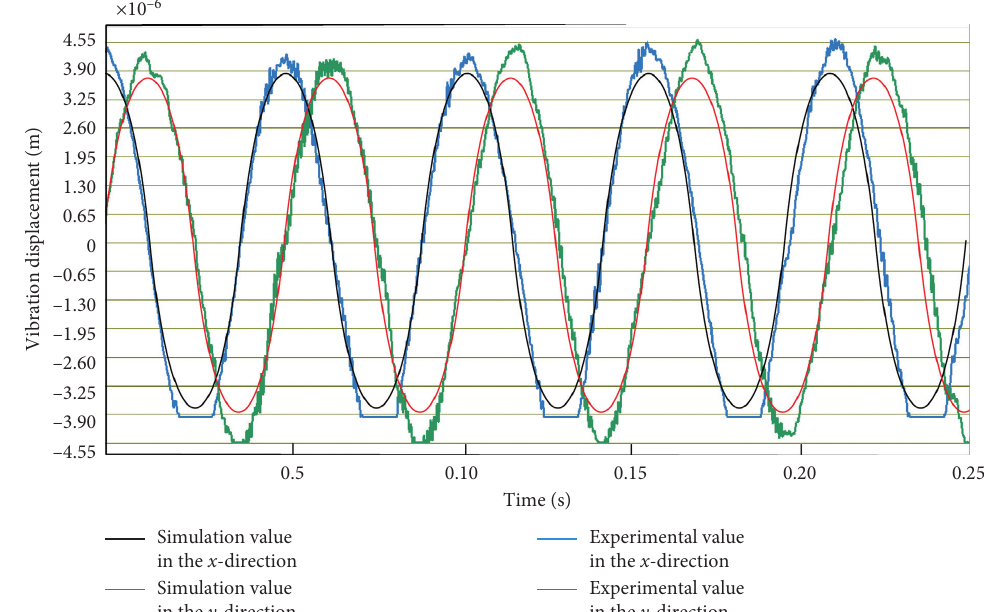
Figure 11: Comparison of experimental values and simulated values of radial vibration displacement at 300 r/min.